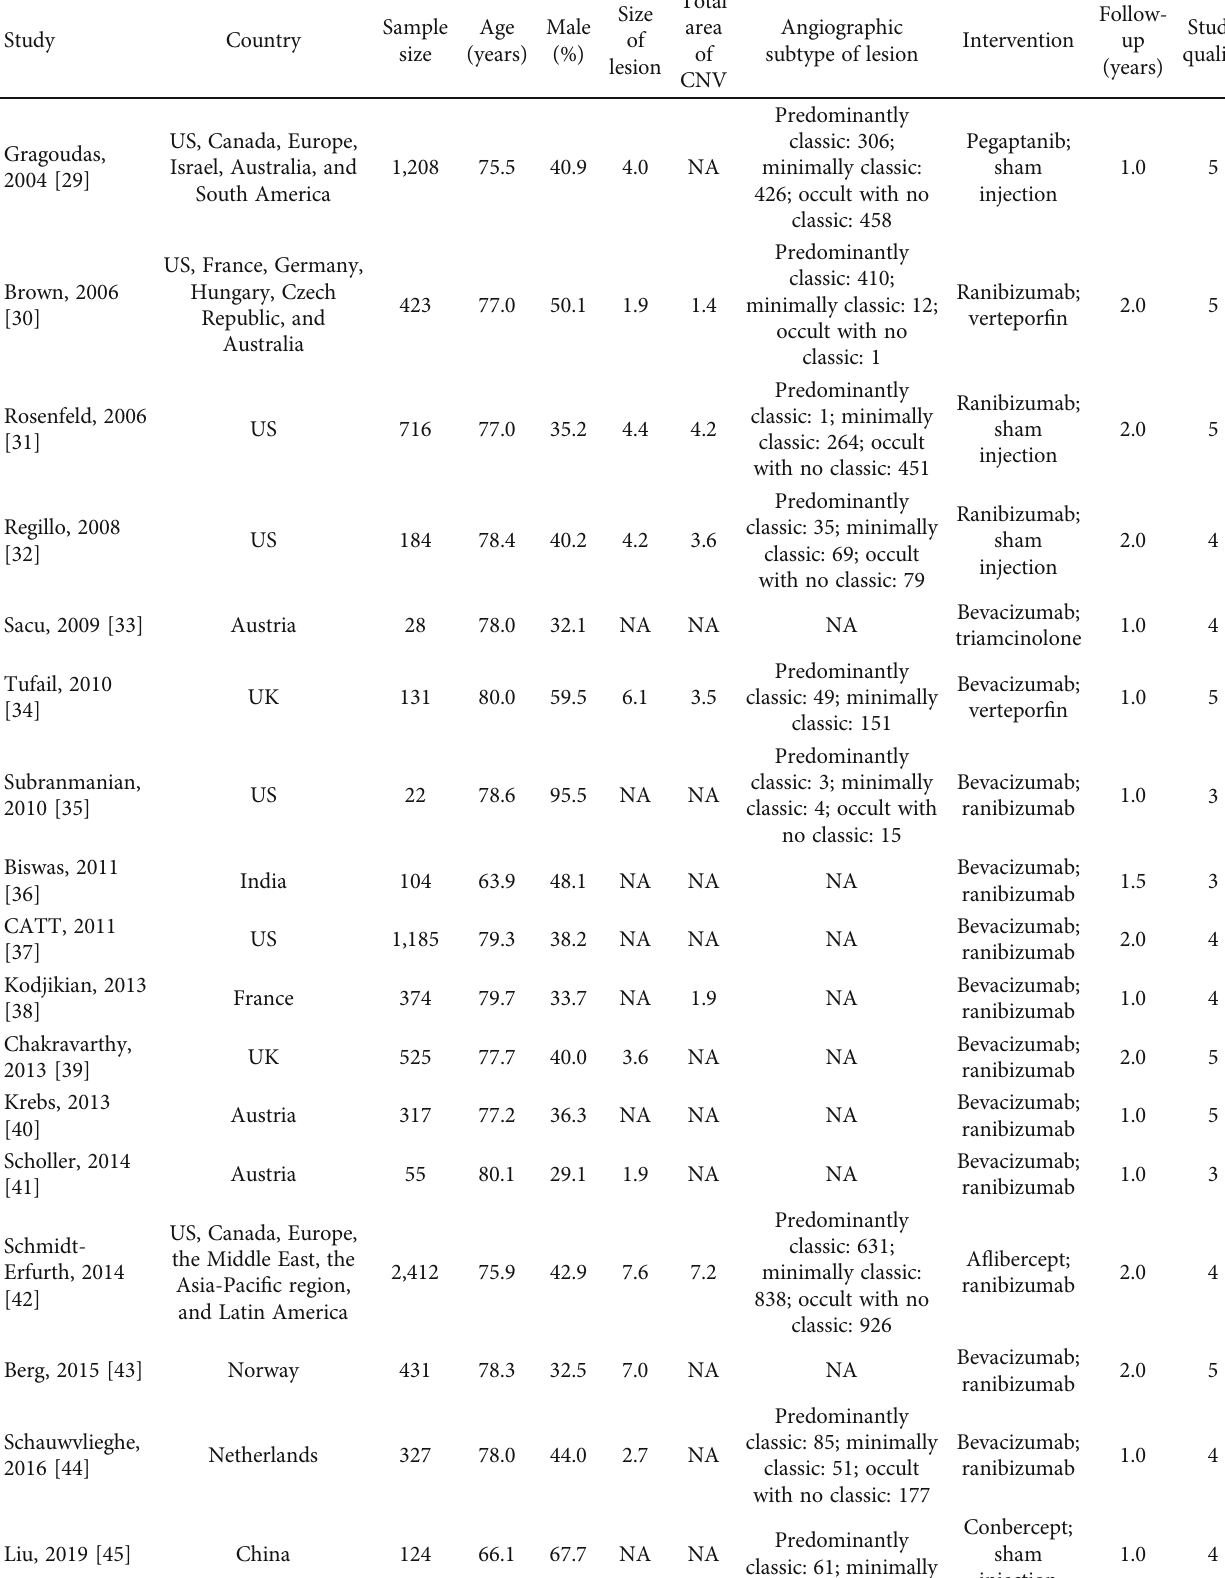
Table 1: The baseline characteristics of identi fi ed studies and enrolled